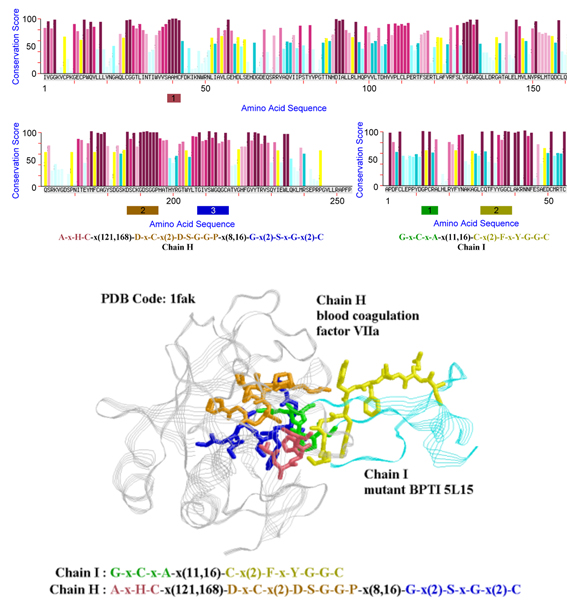
Example used to illustrate how the patterns generated by MAGIIC-PRO facilitate the study of identifying hot regions. The protruding residue Arg15 of 5L15 (chain I) falls in the first block of the derived pattern and the structurally conserved residues in the complemented pocket of VIIa (chain H) can be found in the three blocks of the derived pattern. The patterns are plotted as sticks representation on the structure and colored in the same way as in their regular expression form.